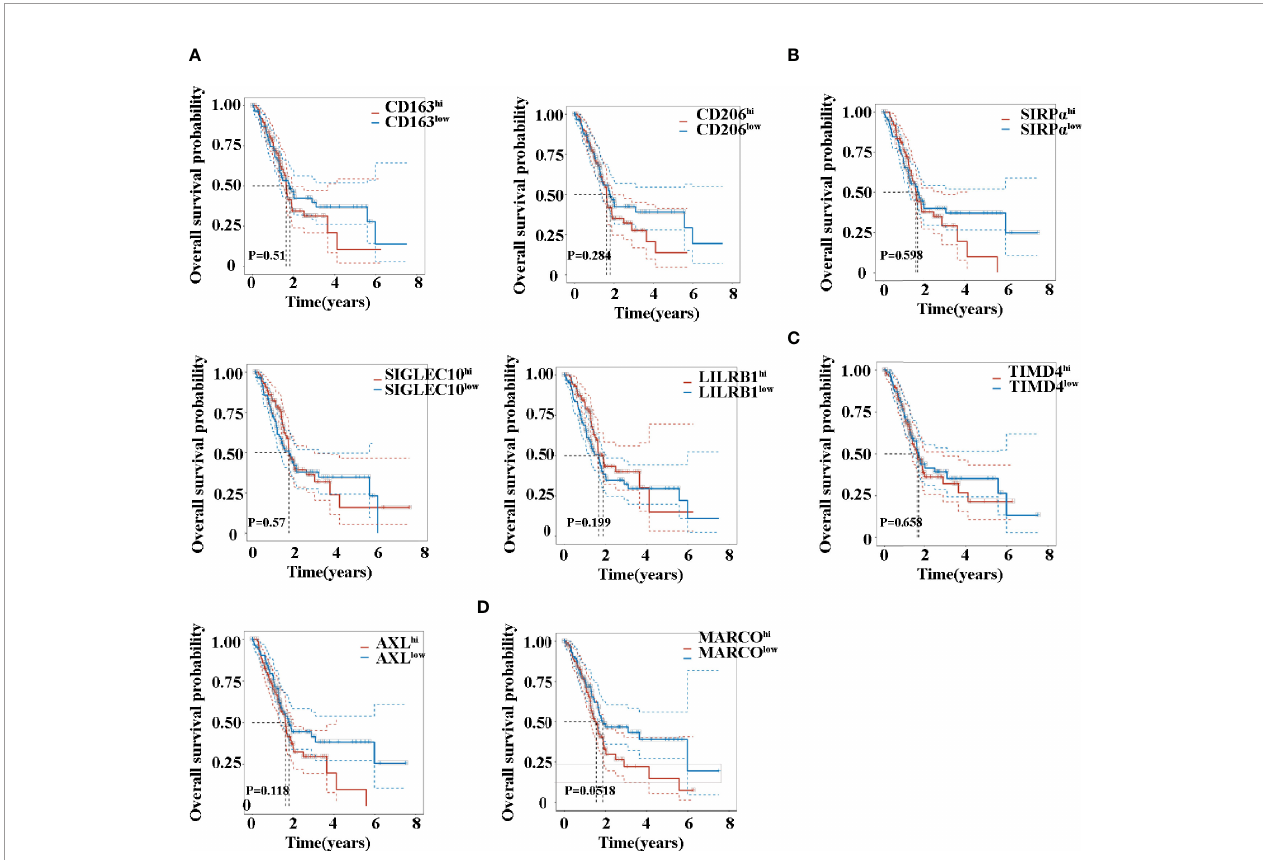
FIGURE 4 | Overall survival time of patients with pancreatic cancer between high and low expression of CD163 (A) , CD206 (A) , SIRP a (B) , SIGLEC10 (B) , LILRB1 (B) , TIMD4 (C) , AXL (C) , and MARCO (D)